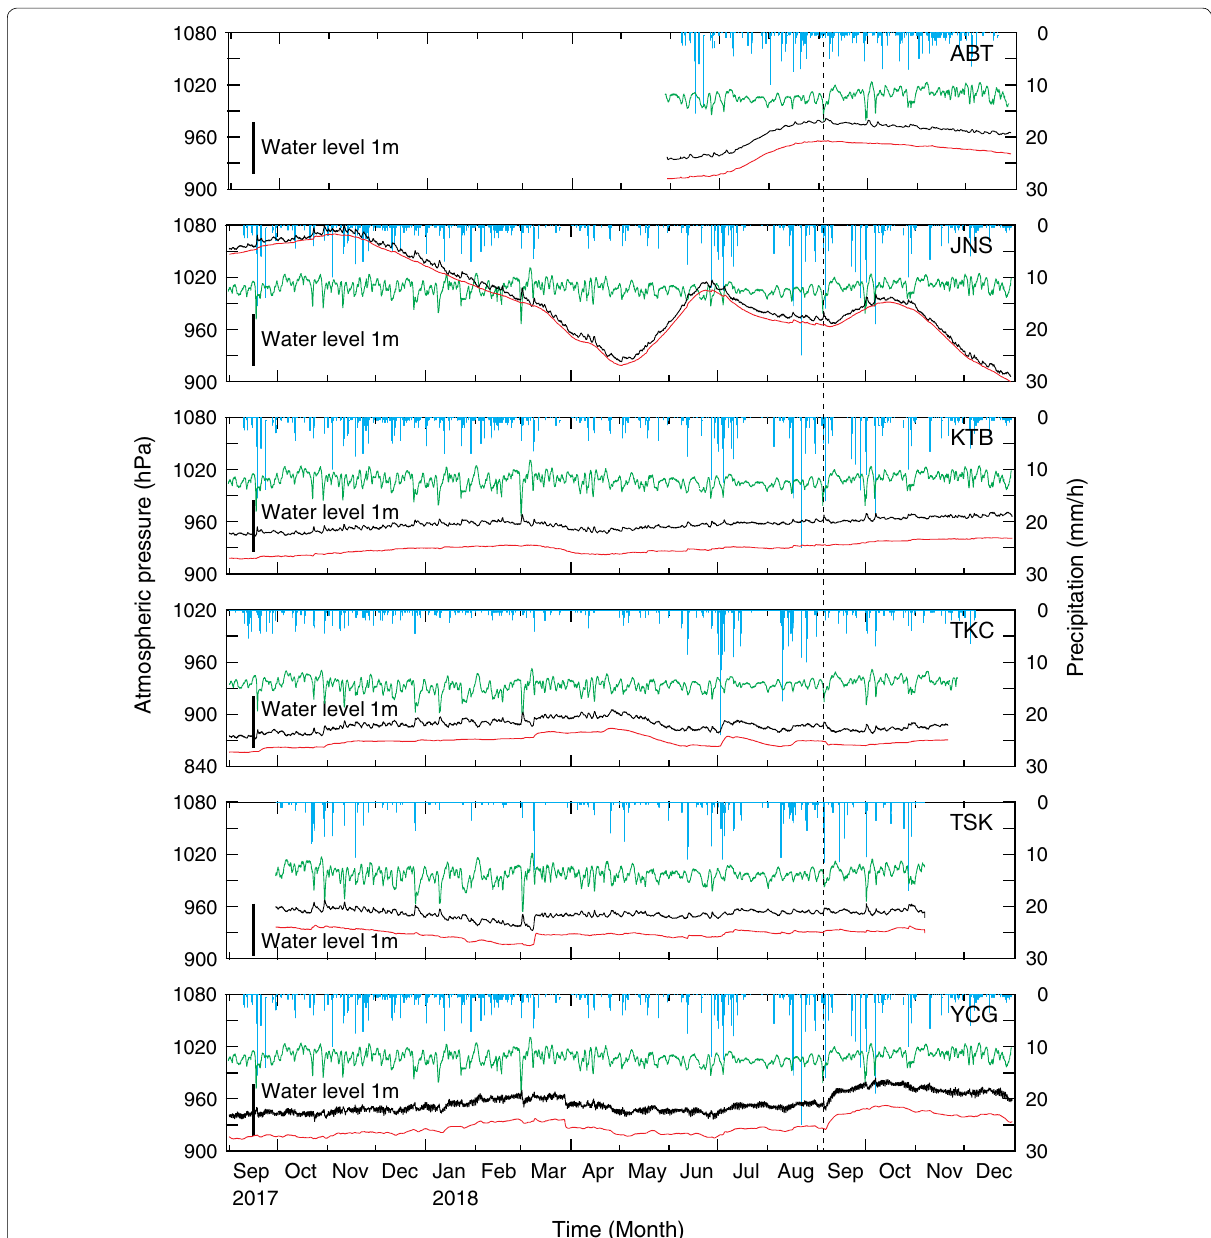
Fig. 2 Observed groundwater levels (black lines) in the monitored observation wells, along with residual groundwater levels (red lines) which removed effects of tidal and atmospheric components (green lines) and rainfall (blue lines) at 1‑h intervals from September 2017 to December 2018. The atmospheric pressure of wells TKC and TSK are measured on the sites, and the other atmospheric pressures and rainfalls are from the Automated Meteorological Data Acquisition System (AMeDAS; Japan Meteorological Agency 2018b). The dotted line indicates the timing of the